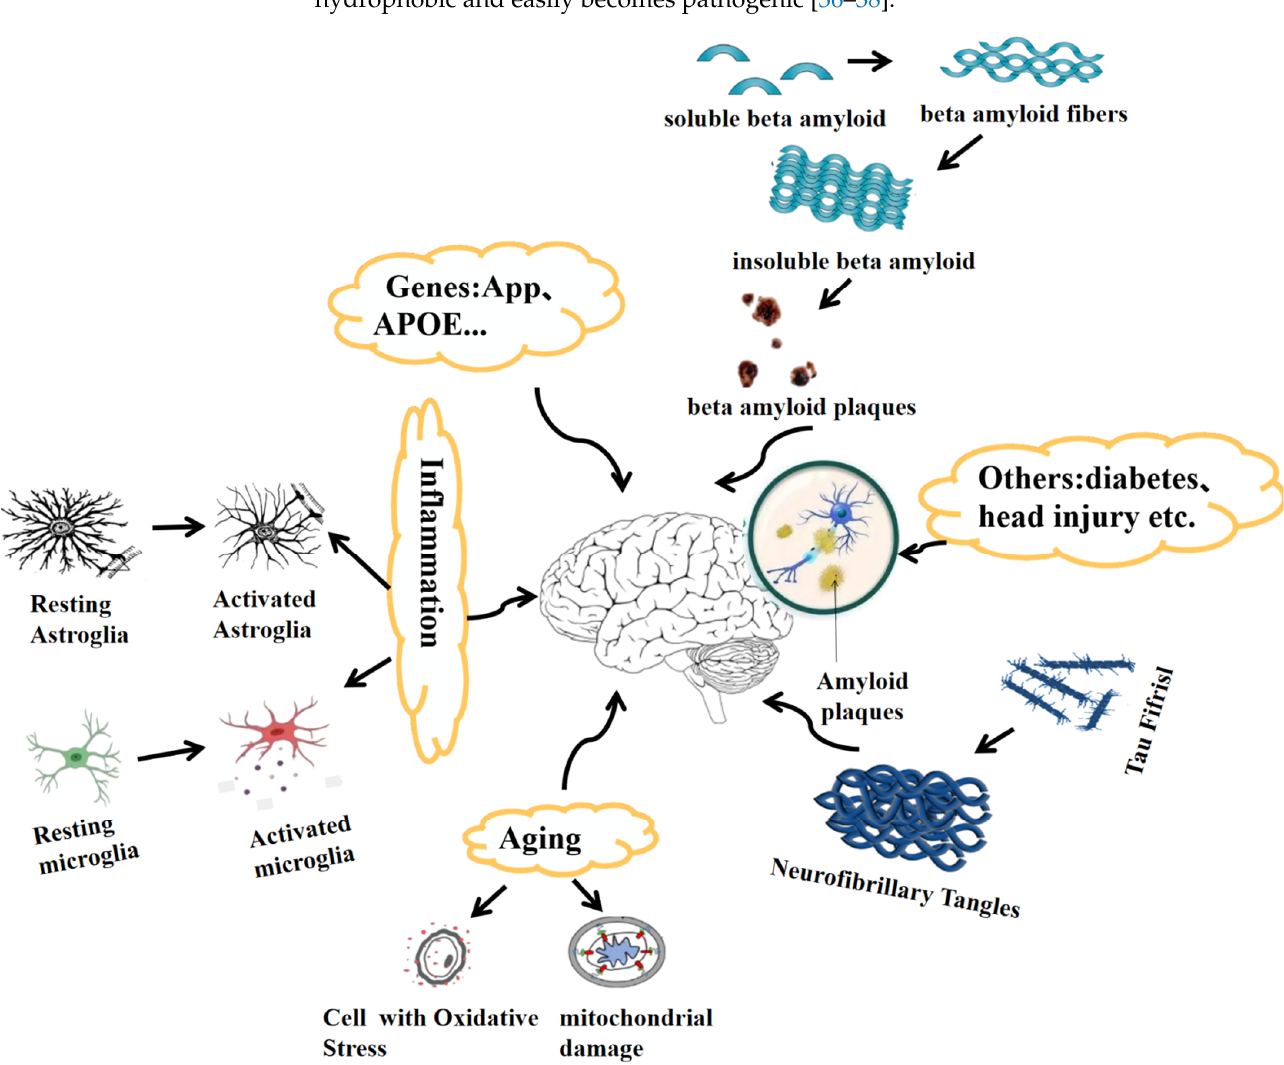
Figure 1. Multifactorial basis of the pathogenesis of Alzheimer’s disease. Hypotheses regarding genetics (APP/A β , apoE4), aging, A β , Tau, and inflammation have been promoted to explain this multifactorial disorder. A β production increases with APP gene mutations, leading to impairment of neuronal activities. Tau forms neurofibrillary tangles and it impairs synaptic functions. Activated microglia and astroglia are important inflammatory factors in AD. Aging increases oxidative stress and mitochondrial dysfunction, which, in turn, improve A β production, Tau hyperphosphorylation, and the generation of inflammation. Comorbidities, such as head injury, diabetes mellitus, and other neurodegeneration diseases, could cause